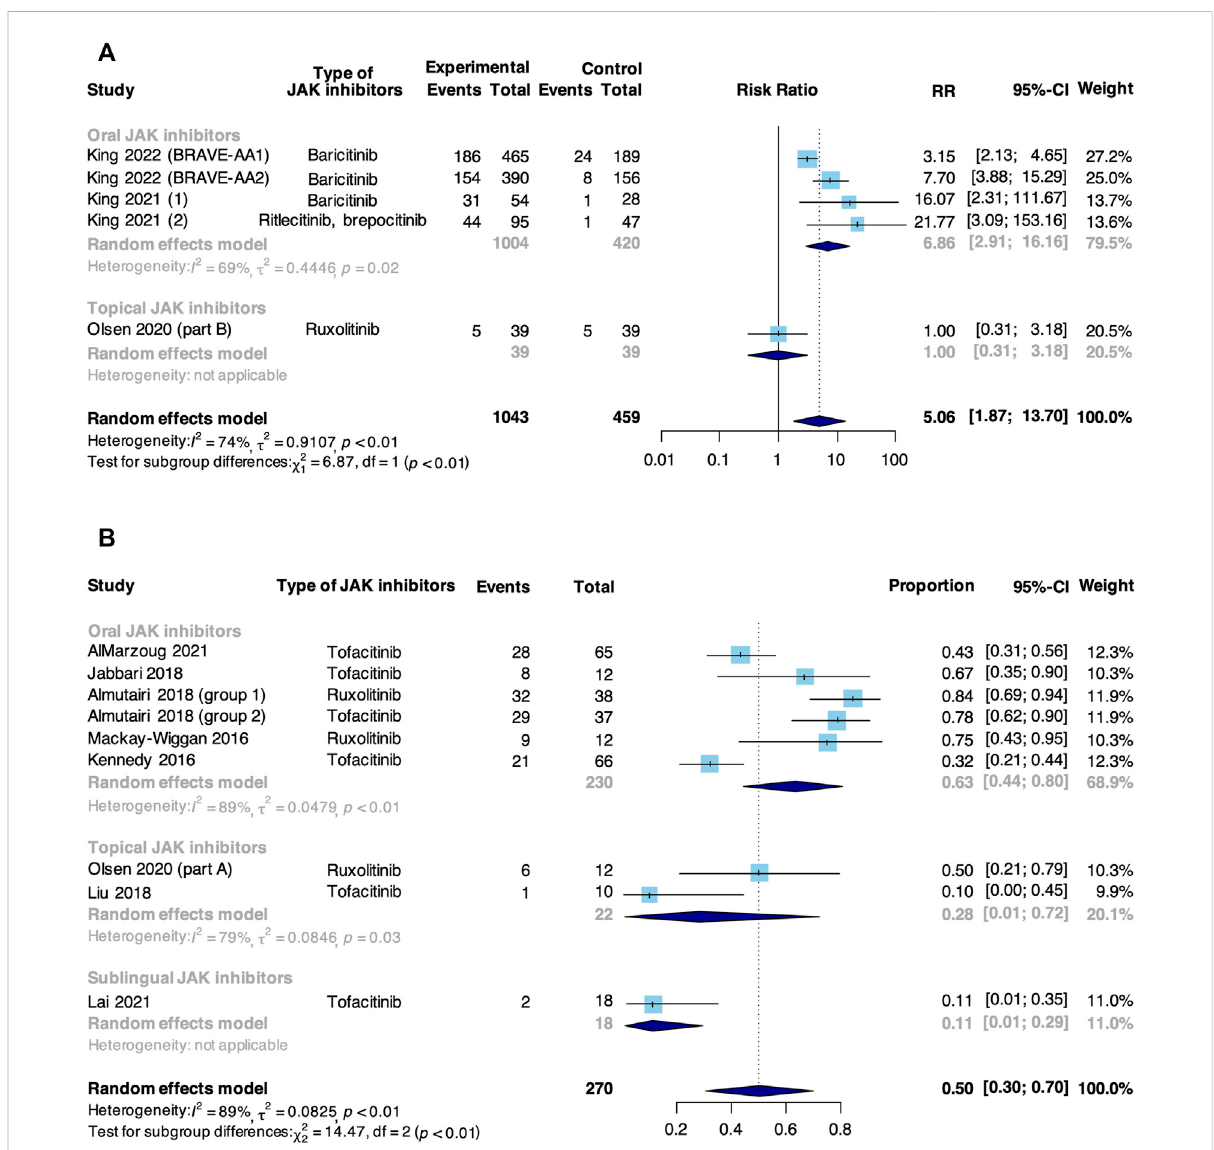
FIGURE 2 Forest plot of the pooled rate of good response to JAK inhibitors in patients with AA based on (A) RCTs and (B)